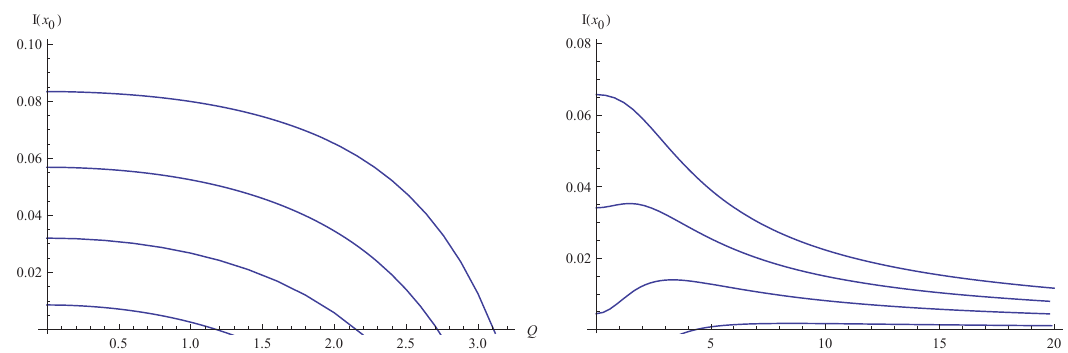
Figure 4 . Left: the relation between I ( x 0 ) and black hole charge Q while (cid:12)xing m = 0 : 6, r h = 1. The curves from top to down correspond to r min increasing from 1.21 to 1.27 with steps 0.02; right: the relation between the mutual information I ( x 0 ) and the graviton mass m by (cid:12)xing Q = 2, r h = 1. Curves from top to down correspond to r min increasing from 1.21 to 1.27 with steps